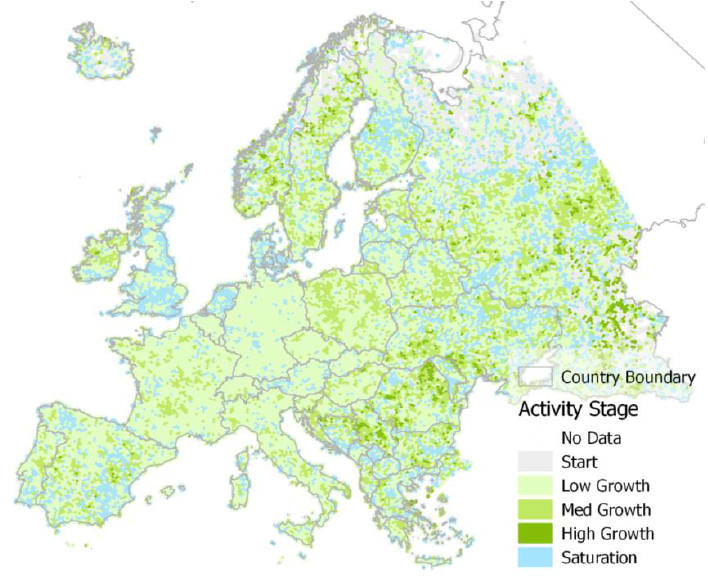
Figure 8. Map visualizing the activity stages for the feature class street in Europe by the end of the year 2014.